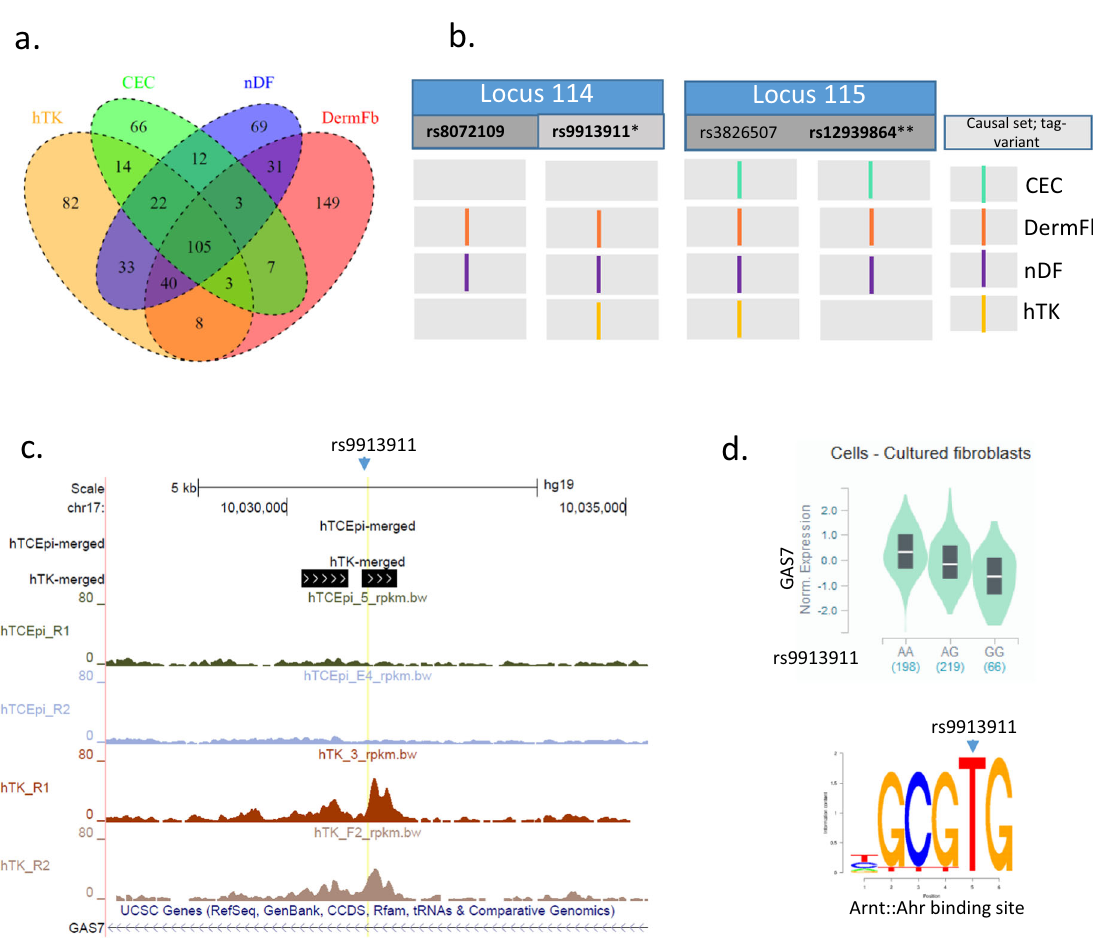
Fig. 3 Regulatory genomic annotations for associated CRF-GWAS variants. a Overlap of open chromatin regions mapped to GWAS variants ( P -value threshold > 10 − 8 or tagging, r 2 > 0.8, variants) across four ATAC-seq datasets signi fi cantly enriched in CRF-GWAS variants. Cell origins: adult cornea epithelium primary tissue (CEC); skin fi broblasts (DermFb); neonate skin fi broblasts (nDF); immortalized corneal keratocytes hTK. b Overlap details at two CRF loci. Variants named are those selected for enrichment analysis based on P -value threshold (tag variant), bold indicates that they belong to